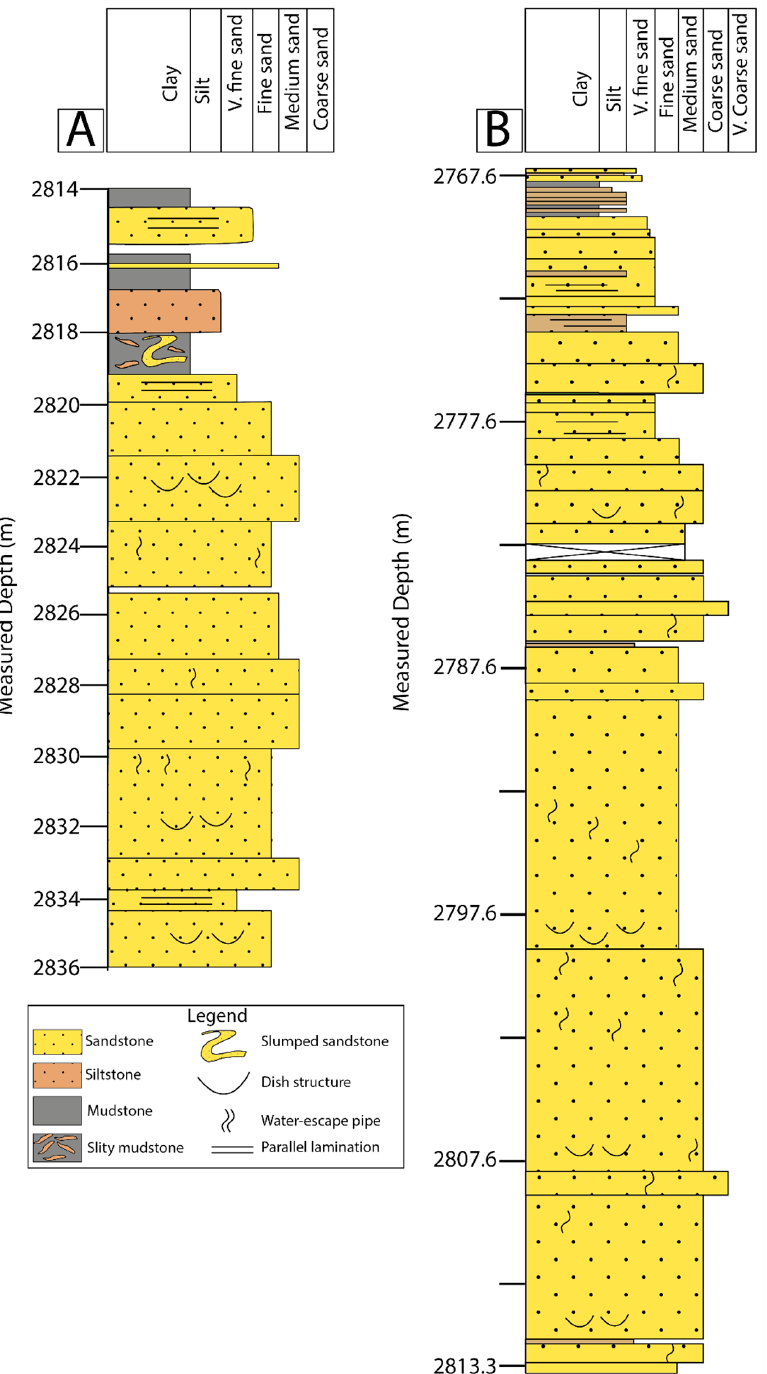
Figure 5. Representative sections of the sedimentary core logs for the Forties Sandstone Member in ( A ) 22/11-6 and ( B ) 22/11-8.